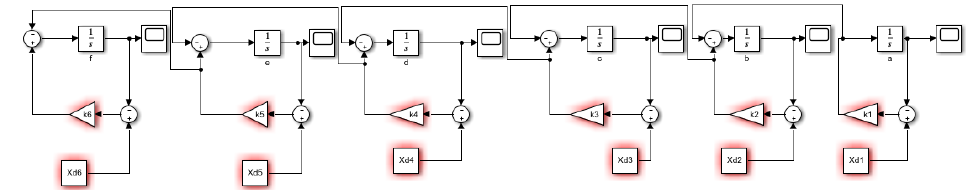
Figure 30. Block diagram of the finishing process, n = 6.